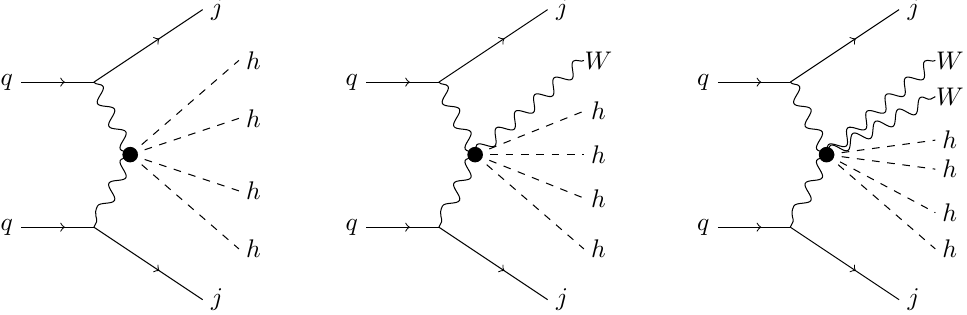
Figure 6 . 4-Higgs production in association with 0–2 W bosons, through the dimension-8 skyrmion operator O Sk , which is denoted by a dot in the